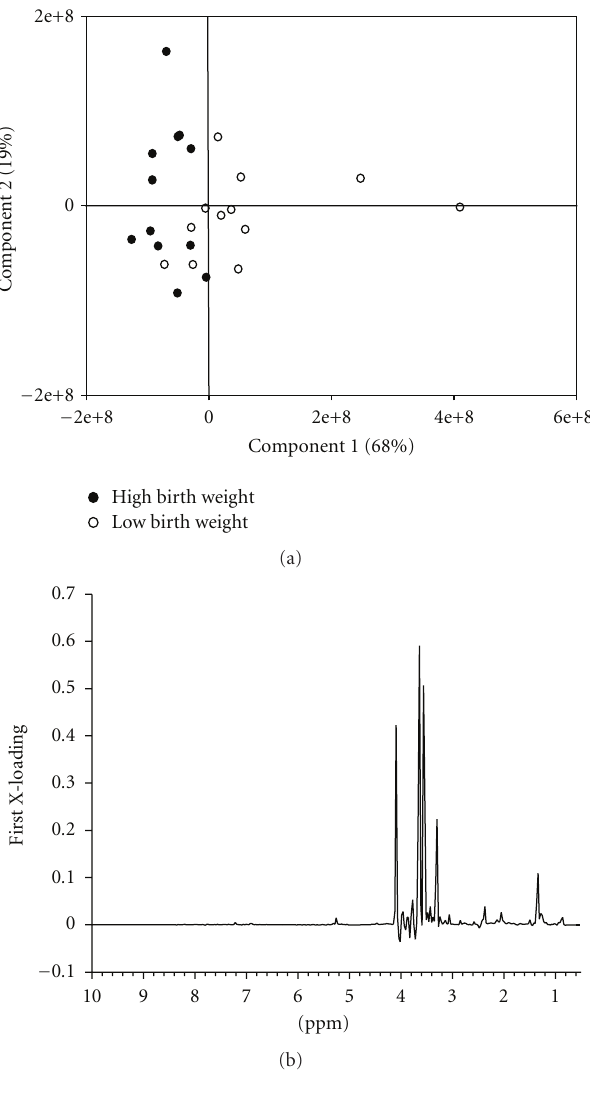
Figure 1: Di ff erences in the 1 H NMR metabolite profile of plasma samples from low birth weight (LW) and high birth weight (HW) piglets. (a) PCA score plot showing the two first principal components for HW piglet samples (closed circles) and LW piglet samples (open circles). (b) Loading plot of first principal